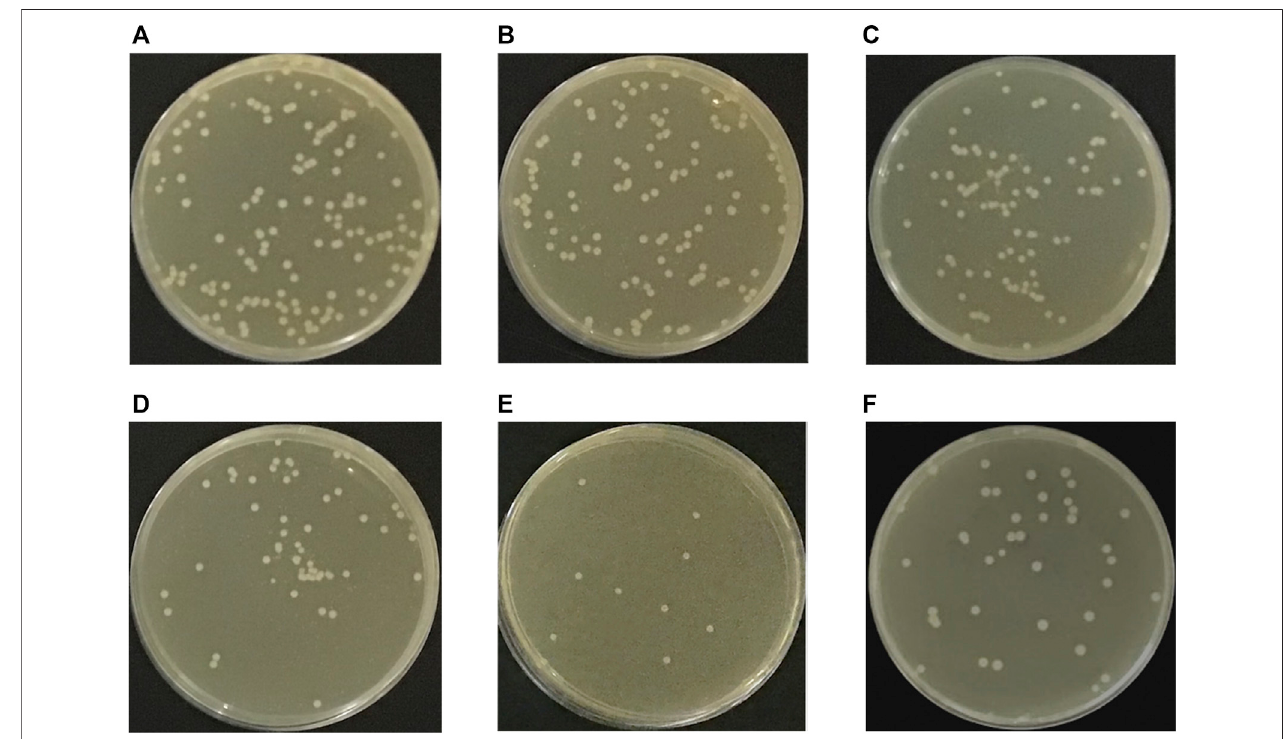
FIGURE 6 | S. mutans colonies on agar of blank group (A) , h-BN-TiO 2 /GIC (0 wt%) and h-BN-TiO 2 /GIC (0.3 wt%), h-BN-TiO 2 /GIC (0.7 wt%), h-BN-TiO 2 /GIC (1.1 wt%), h-BN-TiO 2 /GIC (1.5 wt%) composites (B – F) ,